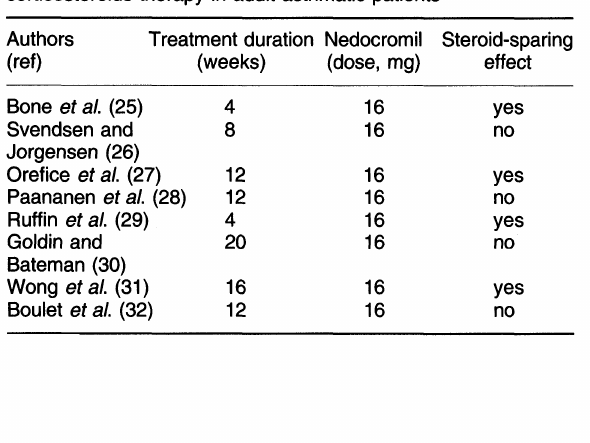
FIG. 4. BDP vs. nedocromil. A Symptoms score (mean change from baseline) in the and II groups treated. "l’abl 5. Nedocromil sodium and steroids: reduction of corticosteroids therapy in adult asthmatic